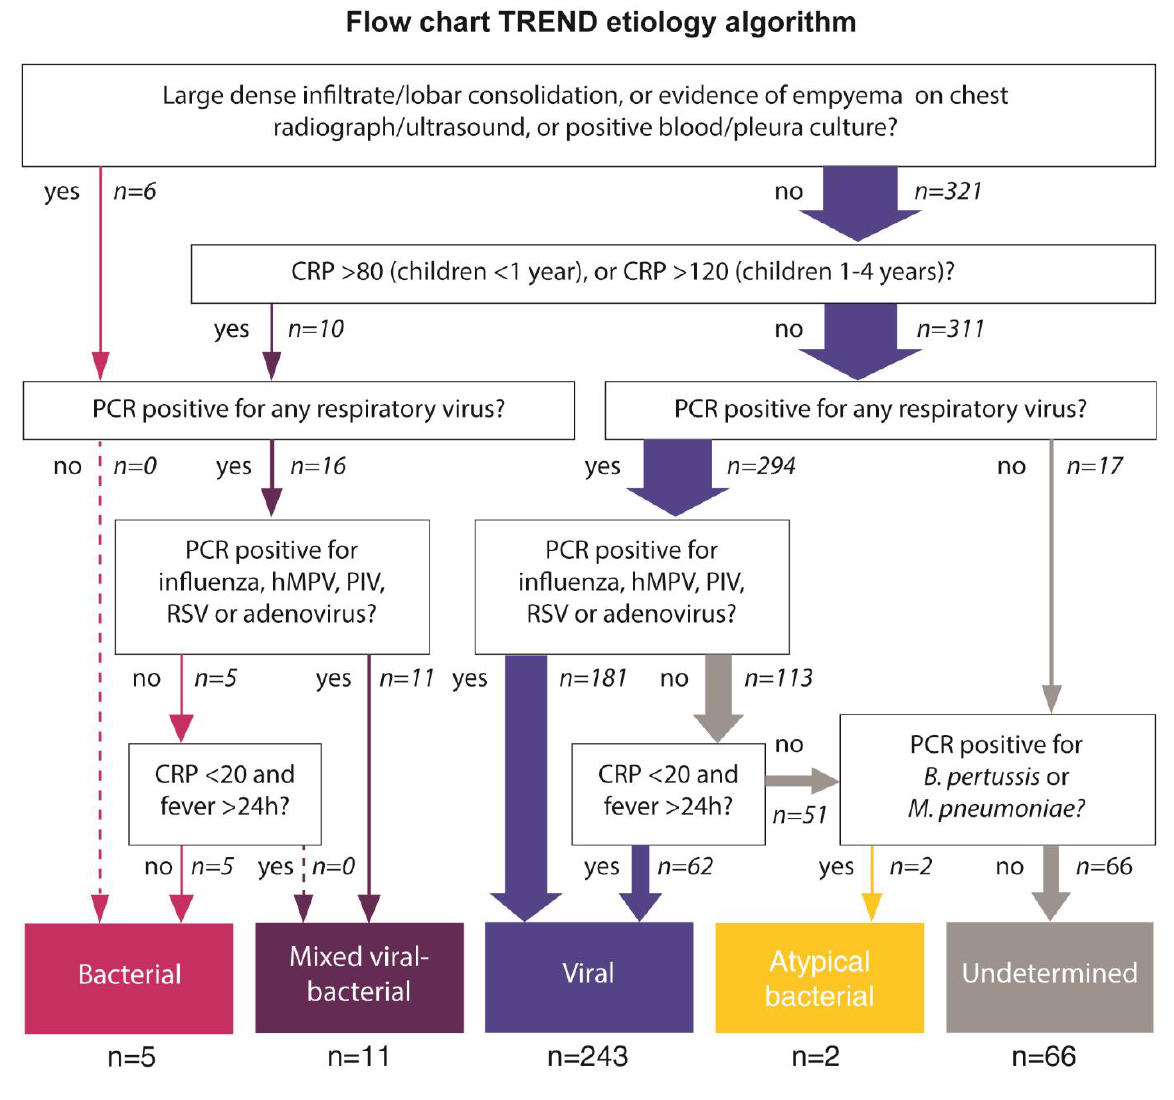
Figure 1. Flowchart of the TREND etiology algorithm. Abbreviations: B. pertussis , Bordetella pertussis ; CRP, C-reactive protein; h, hour; hMPV, human metapneumovirus; M. pneumoniae , Mycoplasma pneumoniae ; PCR, polymerase chain reaction; PIV, parainfluenza virus; RSV, respiratory syncytial virus; TREND, Trial of Respiratory infections for Enhanced Diagnostics.